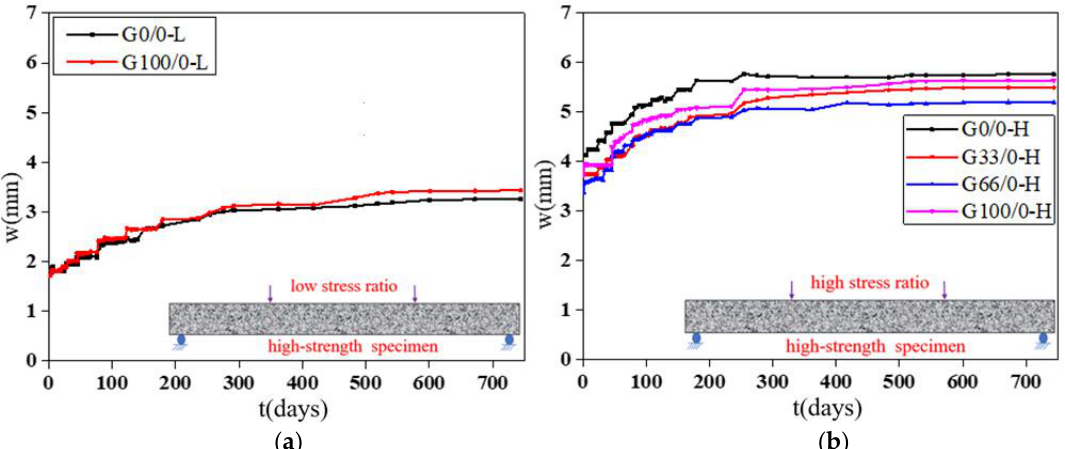
Figure 9. Deflection-load holding time curves of the high-strength specimens. ( a ) Specimens under a low stress ratio; ( b ) specimens under a high stress ratio.